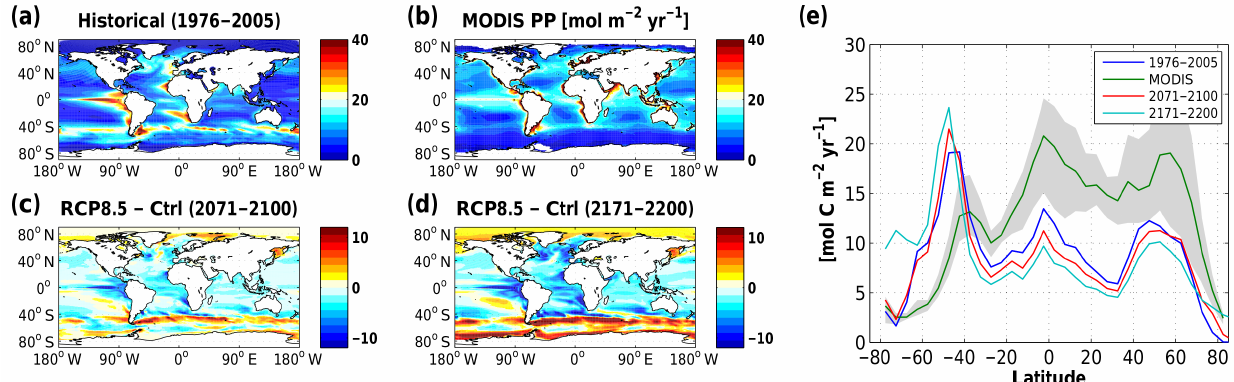
Figure 1. Vertically integrated annual primary production (PP, molCm − 2 yr − 1 ) (a) in the experiment BASE (historical simulation, average over 1976 to 2005), (b) mean of three satellite-based climatologies (derived from MODIS retrievals), (c) change found in the RCP8.5 scenario simulation relative to the control run towards the end of the 21st century (2071 to 2100), and (d) same as (c) but towards the end of the 22nd century (2171 to 2200). Panel (e) displays the zonal means of PP in the BASE historical simulation (dark blue) and for the RCP8.5 scenario (red, light blue). The green line with the grey shaded area represents the mean and range of the zonal means of the three satellite-based climatologies.